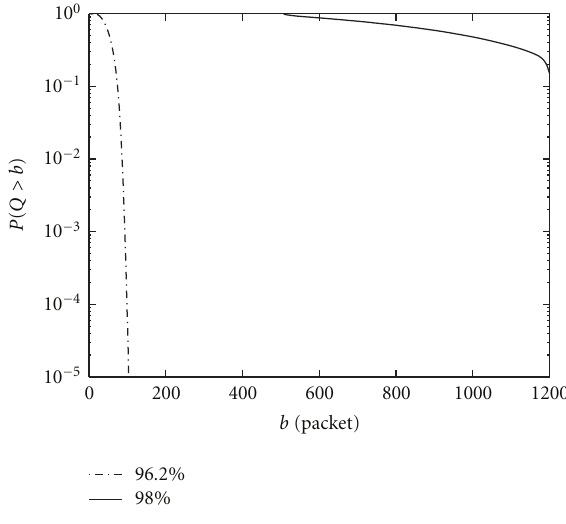
Figure 2: The e ff ect of target utilization.